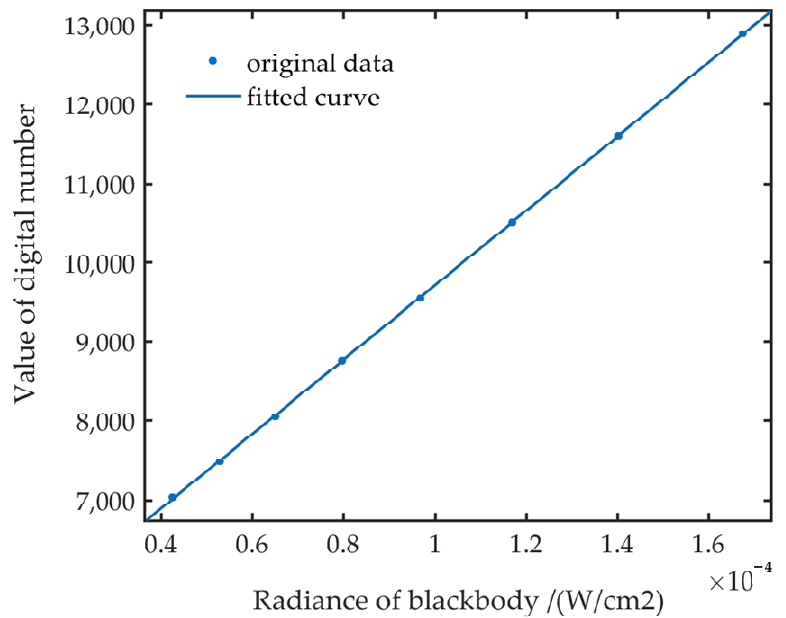
Figure 7. Corresponding relationship between digital response value and blackbody radiance at different temperatures.